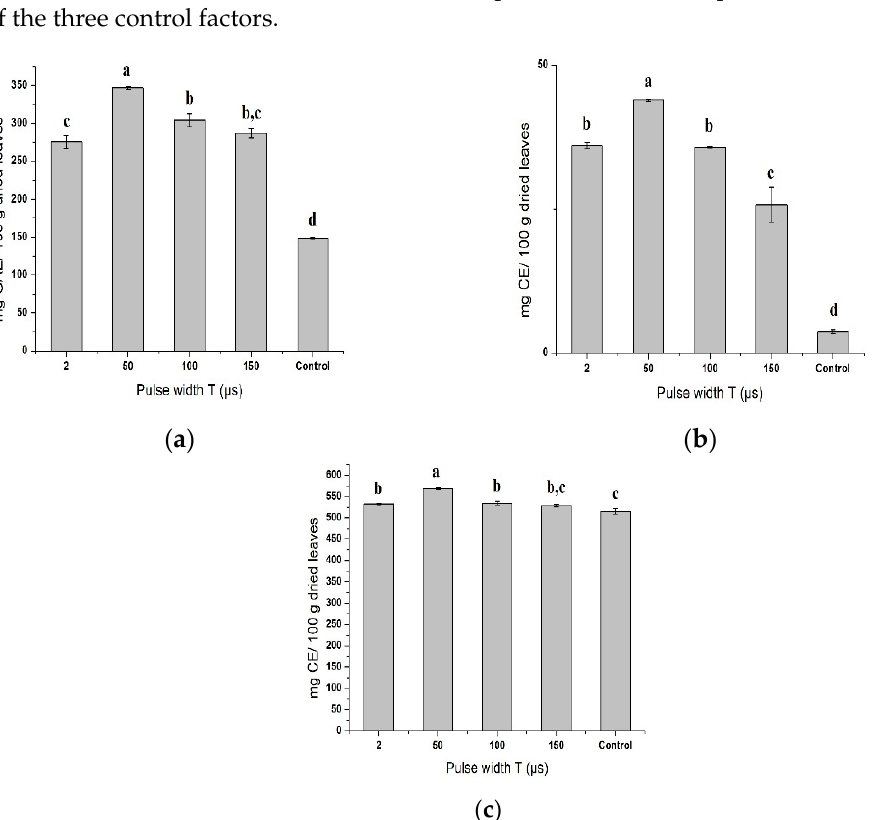
( b ) ( c ) Figure 3. Variation of the phenolic compound extraction yield as a function of the pulse number. ( a )Total phenolic content; ( b )Total flavonoid content; (c) Condensed tannin content. Means not shar- ing any letters are significantly different.